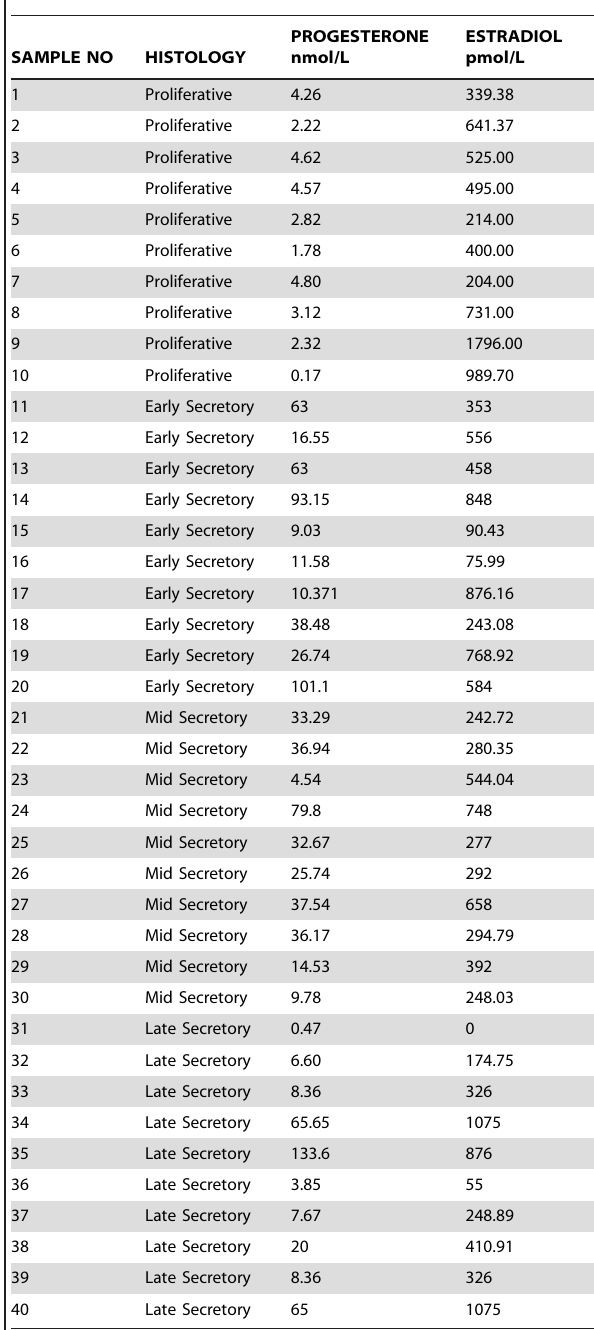
Table 2. Clinical parameters for normal endometrial samples from proliferative phase, early secretory, mid secretory and late secretory phase endometrium